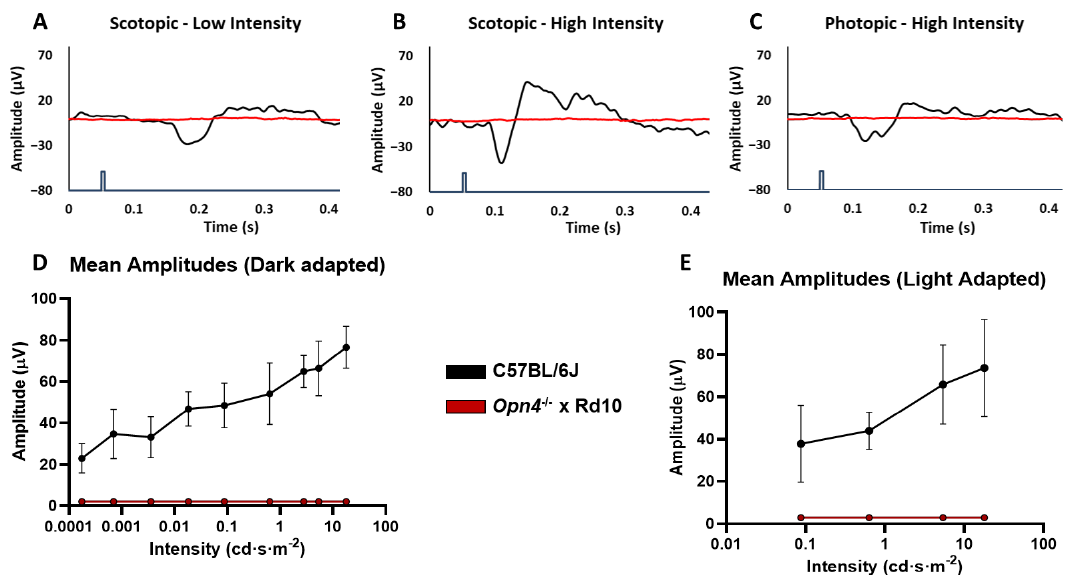
Figure 6. Visual evoked potentials (VEP). Record of the waves corresponding to the strains C57BL/6J and Opn4 − / − × Rd10 in a dark adaptation situation with low light intensity ( A ), dark adaptation with high light intensity ( B ), light adaptation with high light intensity ( C ). Amplitude histogram of scotopic N1-P2, mixed N1-P2, and photopic N1-P2 waves, ( D ), lighting intensity curves – response amplitude in dark adaptation situation ( E ) and light adaptation situation ( F ). The animal model Opn4 − / − × Rd10 was not capable of evoking any VEP in the visual cortex in response to light stimuli ( p < 0.001). The blue line represents the light stimulus. Data is presented as the average ± SD.